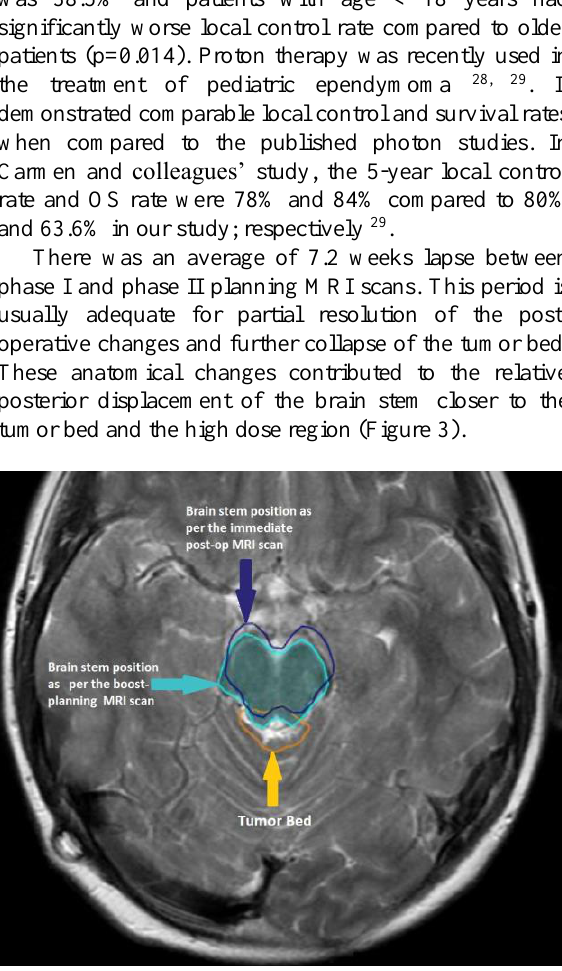
Figure 3: Brain stem position displacement prior to boost